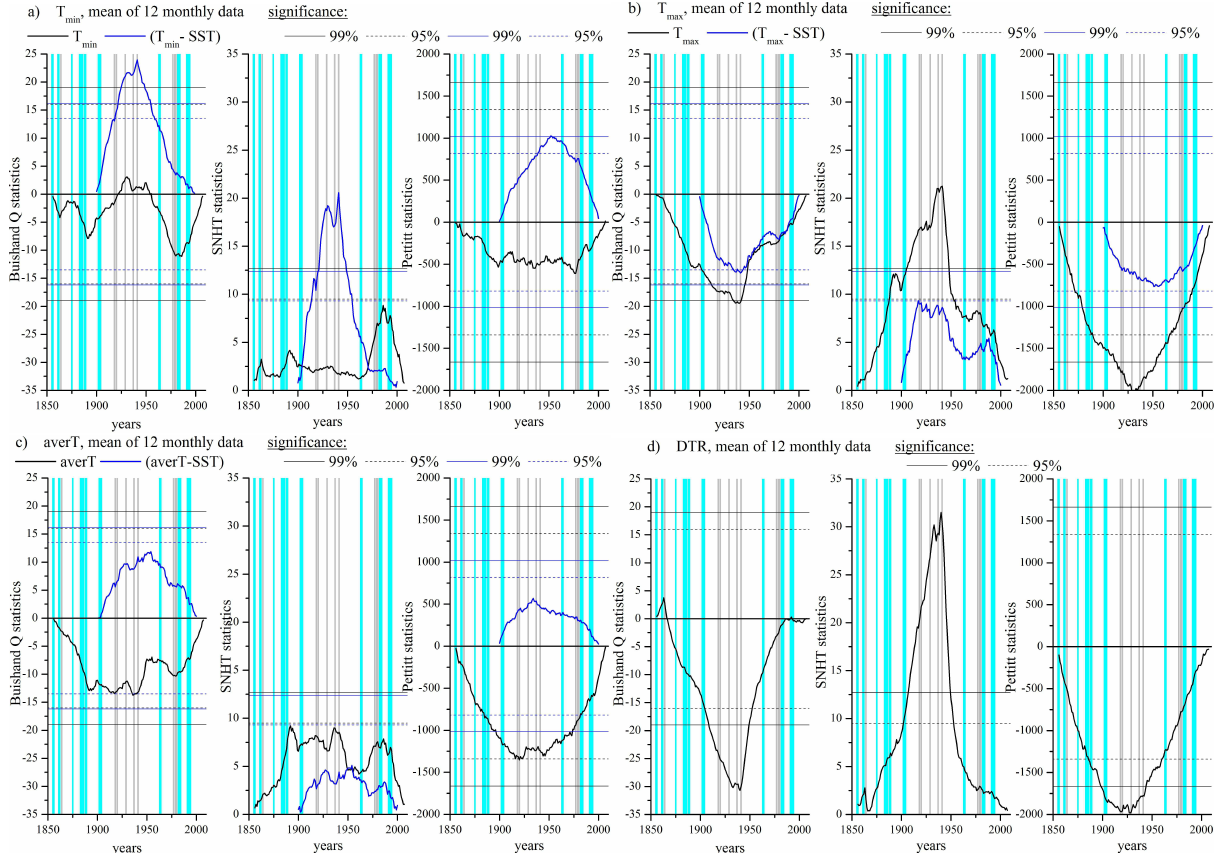
Figure 13. Lisbon: average of 12 monthly series of Buishand Q test (left panels), SNHT (middle panels) and Pettitt tests (right panels) statistics of T min (a) , T max (b) , T aver (c) and DTR (d) . Statistics of temperature series are shown in black, statistics of di ff erences between temperature and SST series are shown in blue. Solid and dashed horizontal lines show probability levels of 99% and 95%, respectively. Grey vertical lines show known dates of instrumental changes, cyan broad vertical lines show periods of strong volcanic